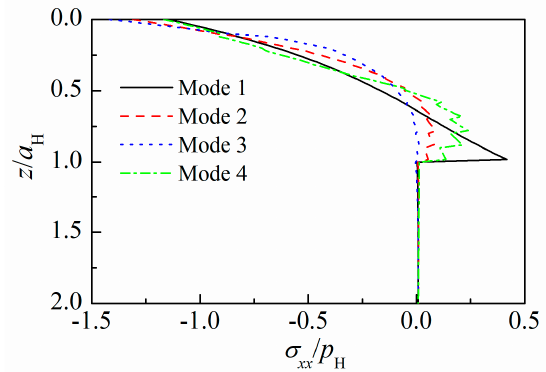
Figure 6. The stress σ xx along z axis of multilayered coatings with different elasticity modulus changing modes when friction coefficients μ f is 0.